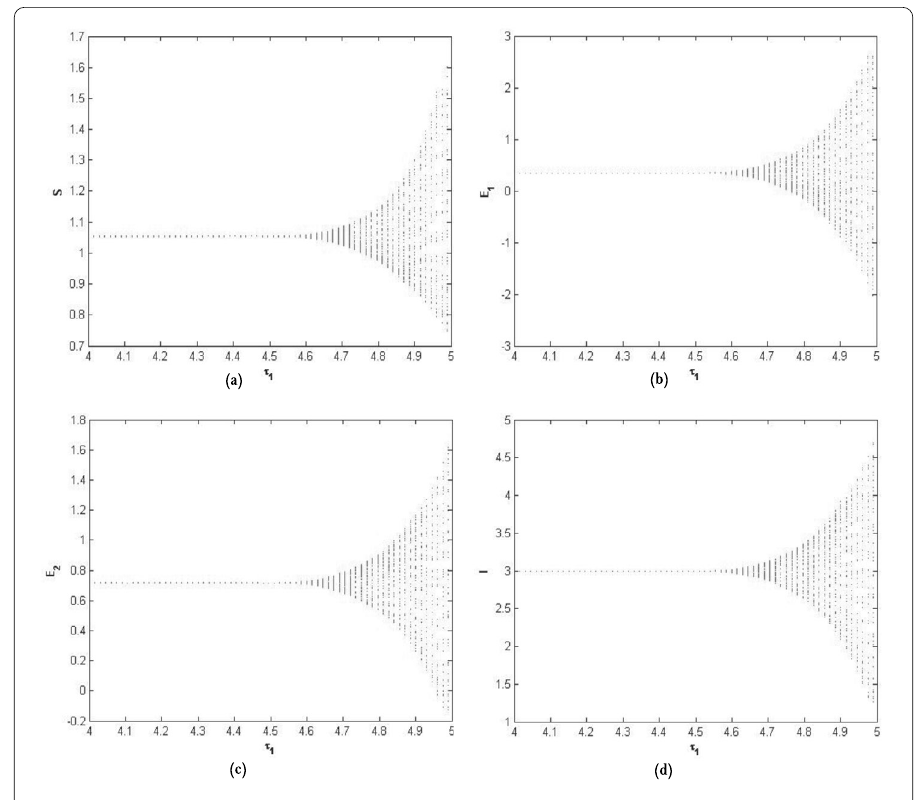
Figure 3 The bifurcation diagram with respect to τ 1 when τ 2 = 4.25 ∈ (0, τ 20